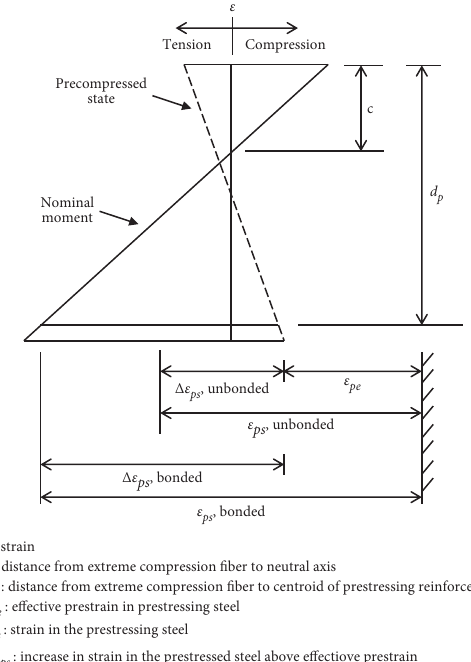
Figure 1: Strain distribution comparison at section of the maxi- mum